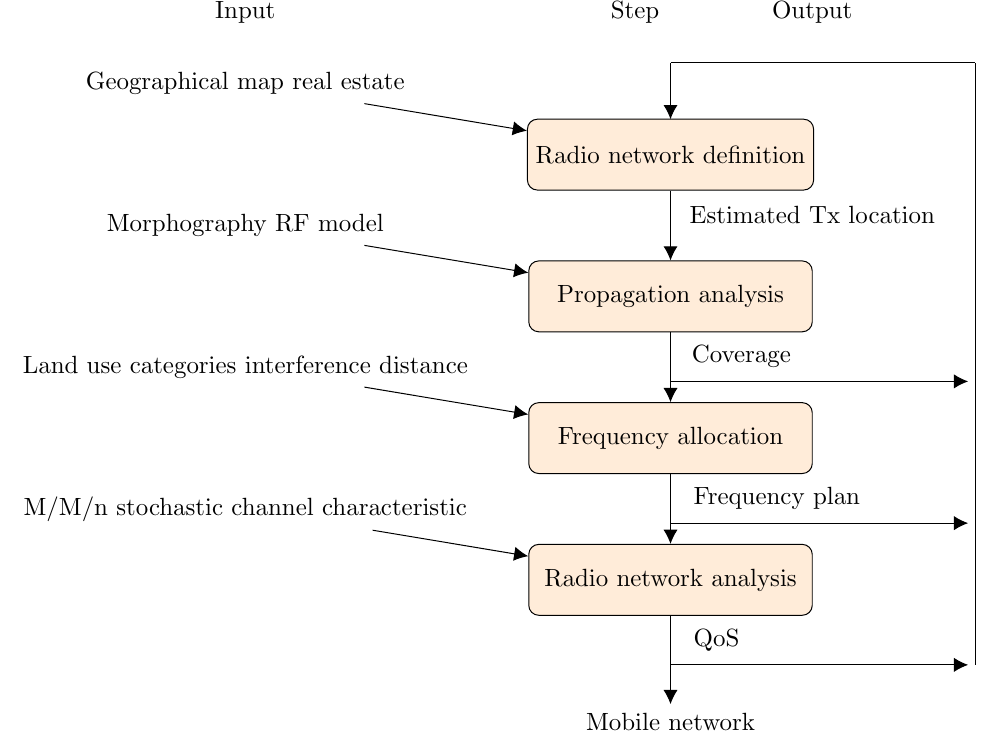
Figure 1. Conventional approach to cellular network